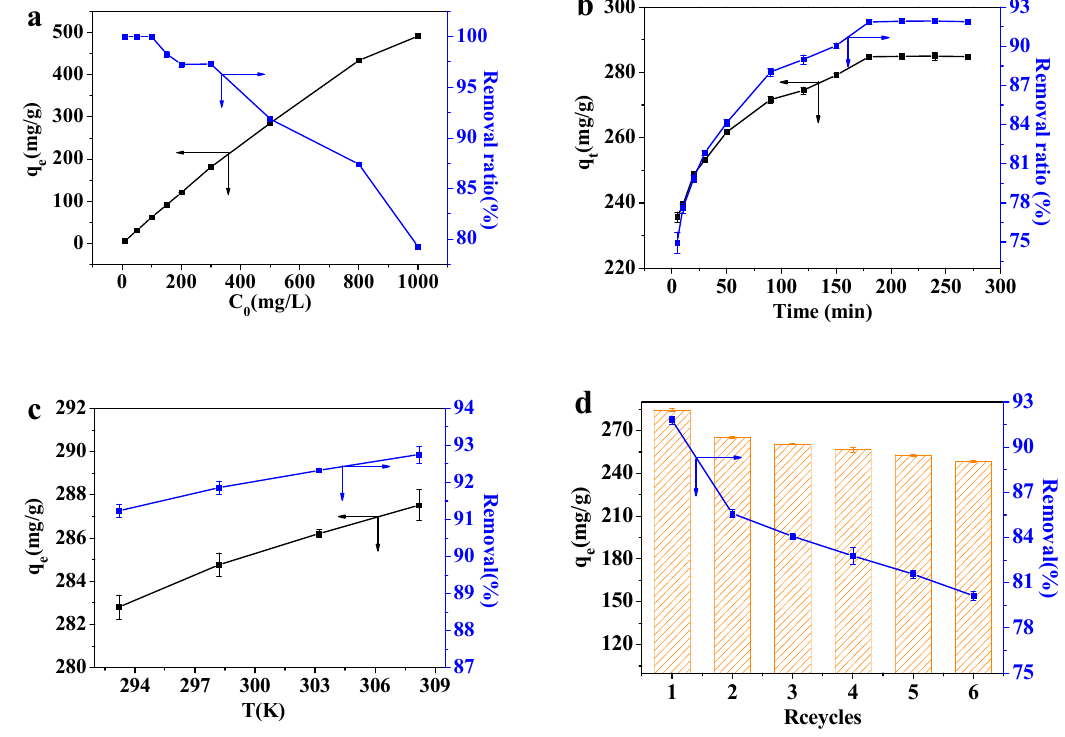
Figure 5. The effect of ( a ) initial Pb(II) concentration; ( b ) adsorption time; ( c ) adsorption temperature, ( d ) adsorption–elution recycling on adsorption